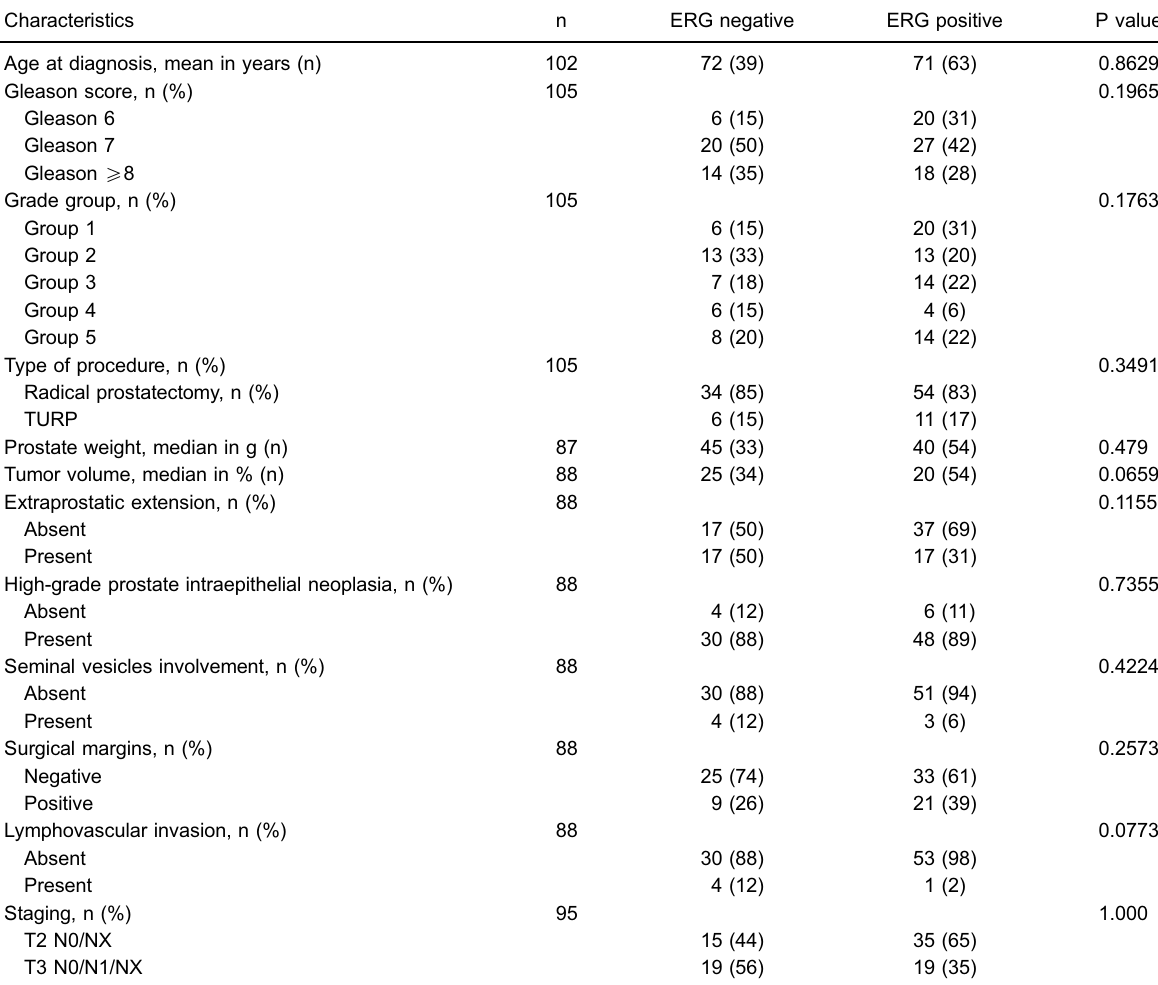
Table 3. Association of measured phosphatase tensin homolog (PTEN) and clinicopathological characteristics of men treated with radical prostatectomy or transurethral resection of the prostate (TURP) for prostate cancer.